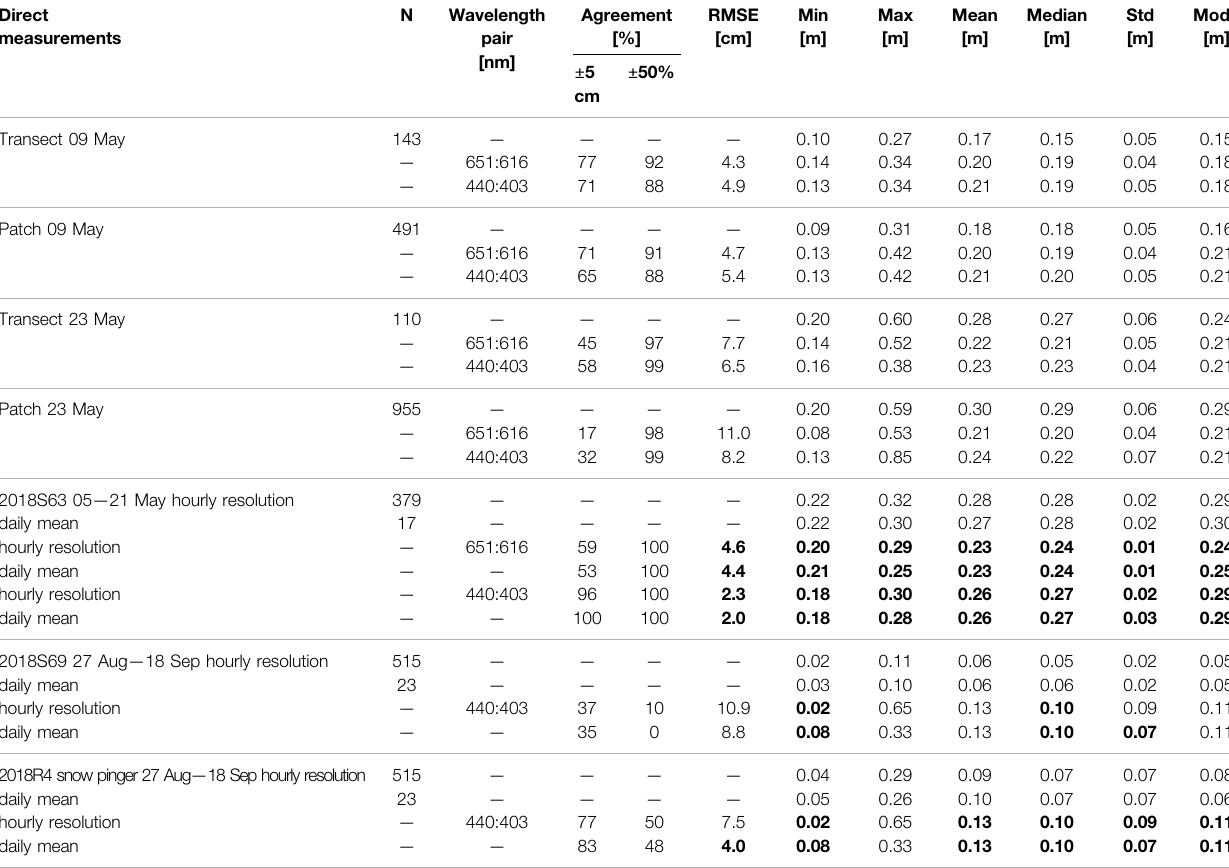
TABLE 4 | Comparison of snow depth retrieval using the NDI method. The modes were read from histograms with 1 cm bin width. N is the number of measurements used. Direct